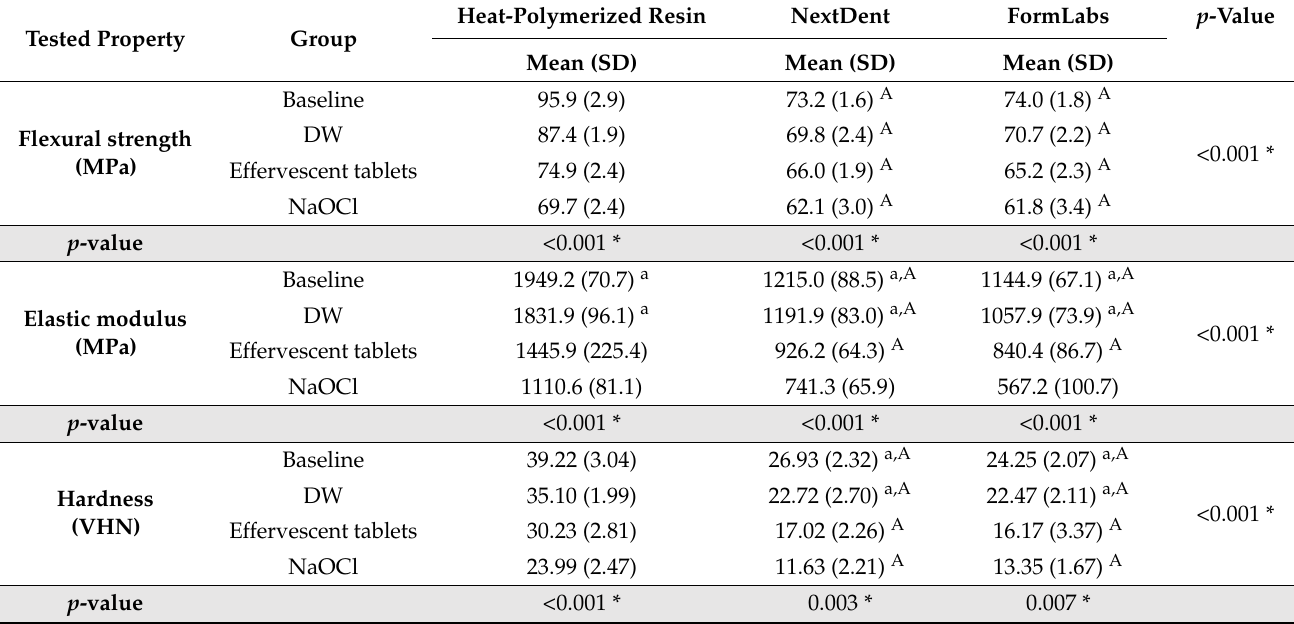
Table 3. Means, SDs, and significant differences between the groups for all tested